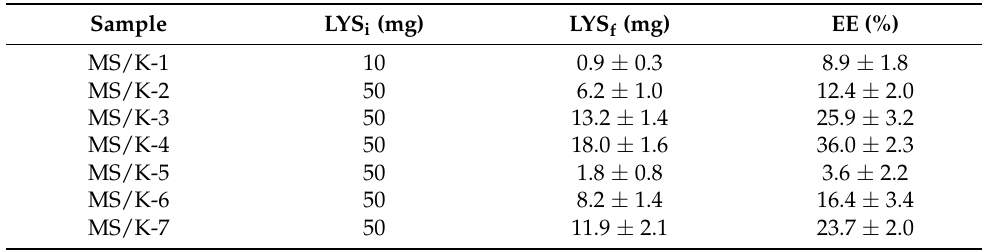
Table 4. Effects of synthesis parameters on MS/K encapsulation efficiency (EE%). Reported values represent mean ± SD (n =